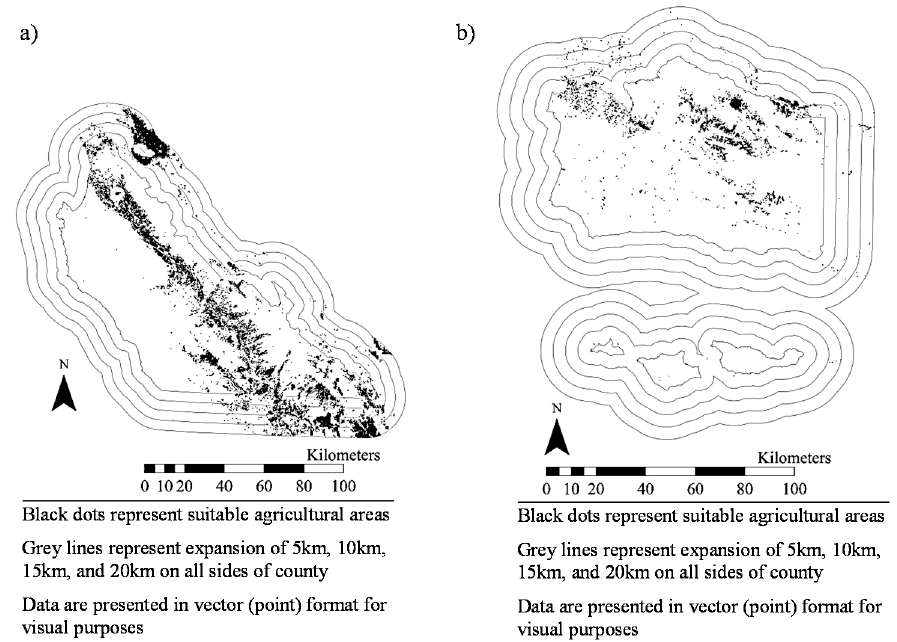
Figure 3. Suitable agricultural land for broccoli in ( a ) Monterey County, California and ( b ) Santa Barbara County, California.